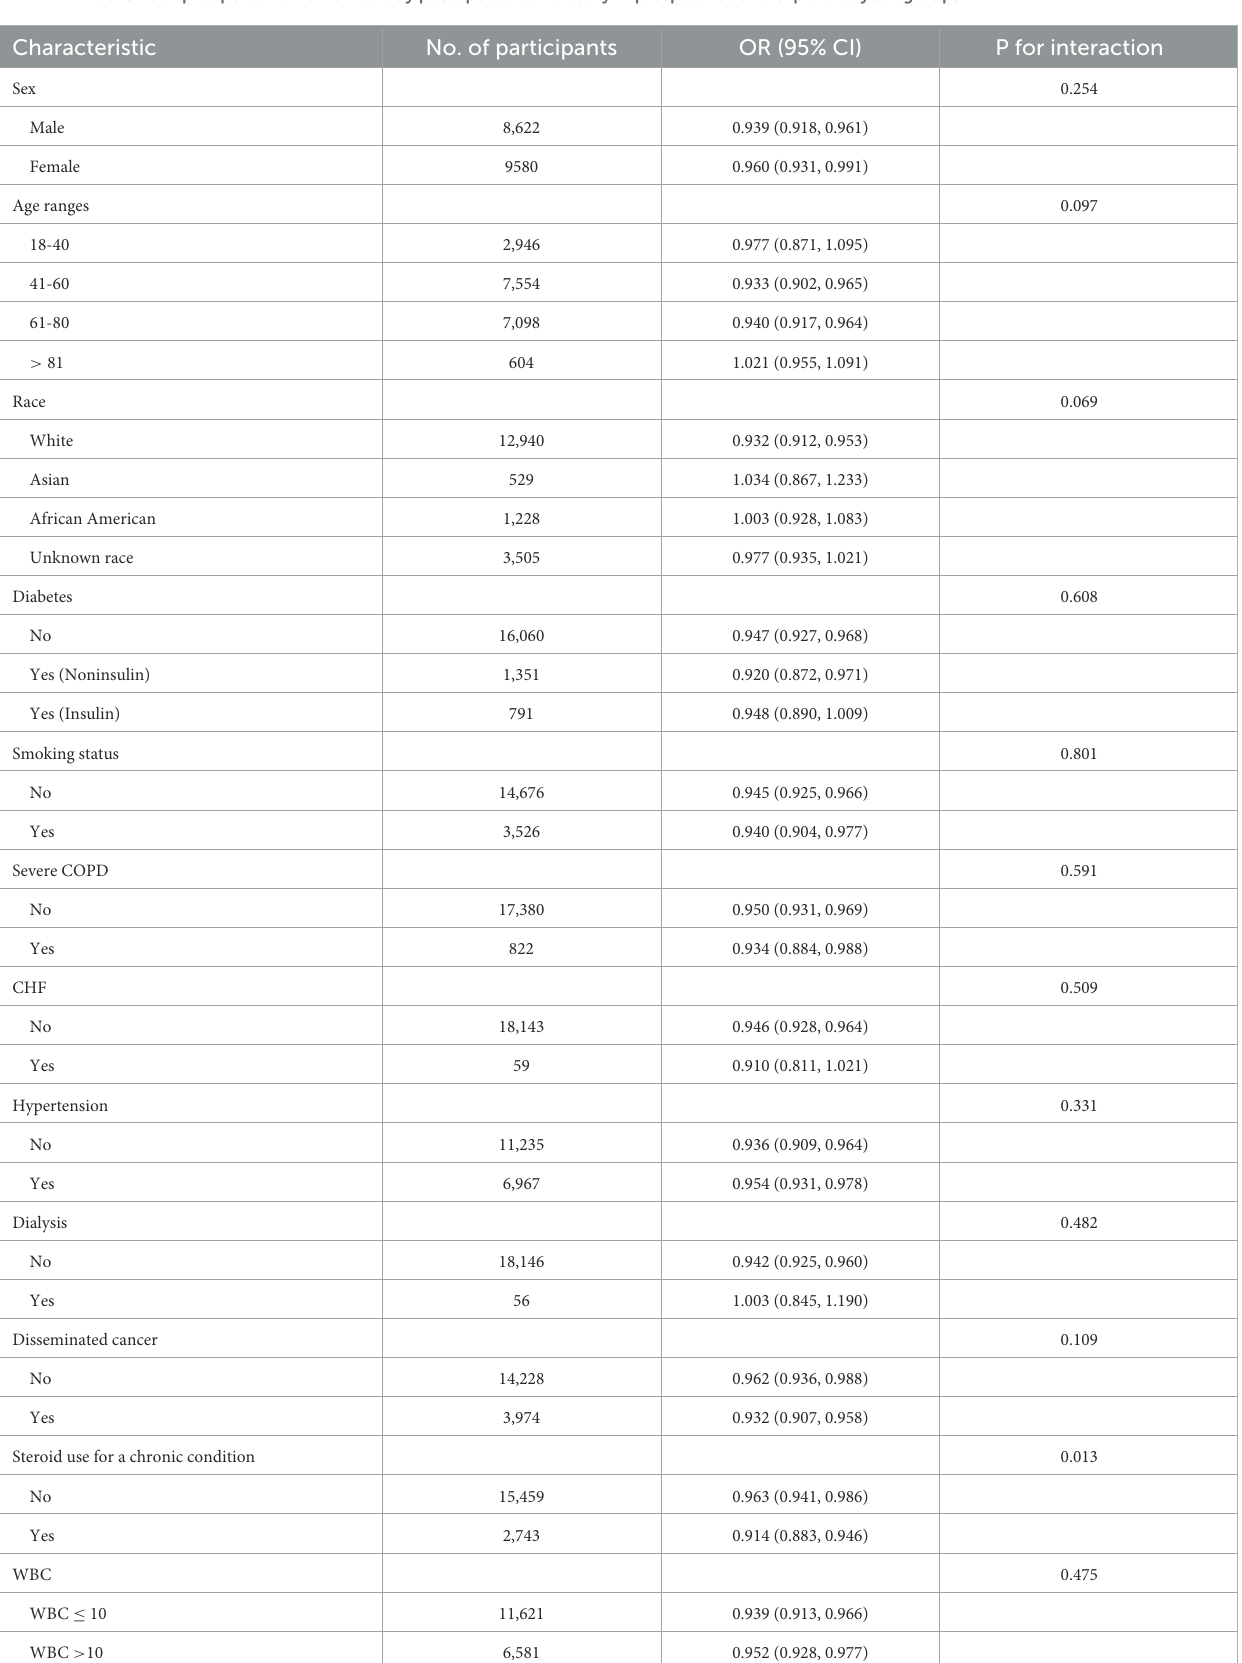
TABLE 4 Effect size of preoperative HCT on 30-day postoperative mortality in prespecified and exploratory subgroups. Characteristic No. of participants OR (95% CI) P for